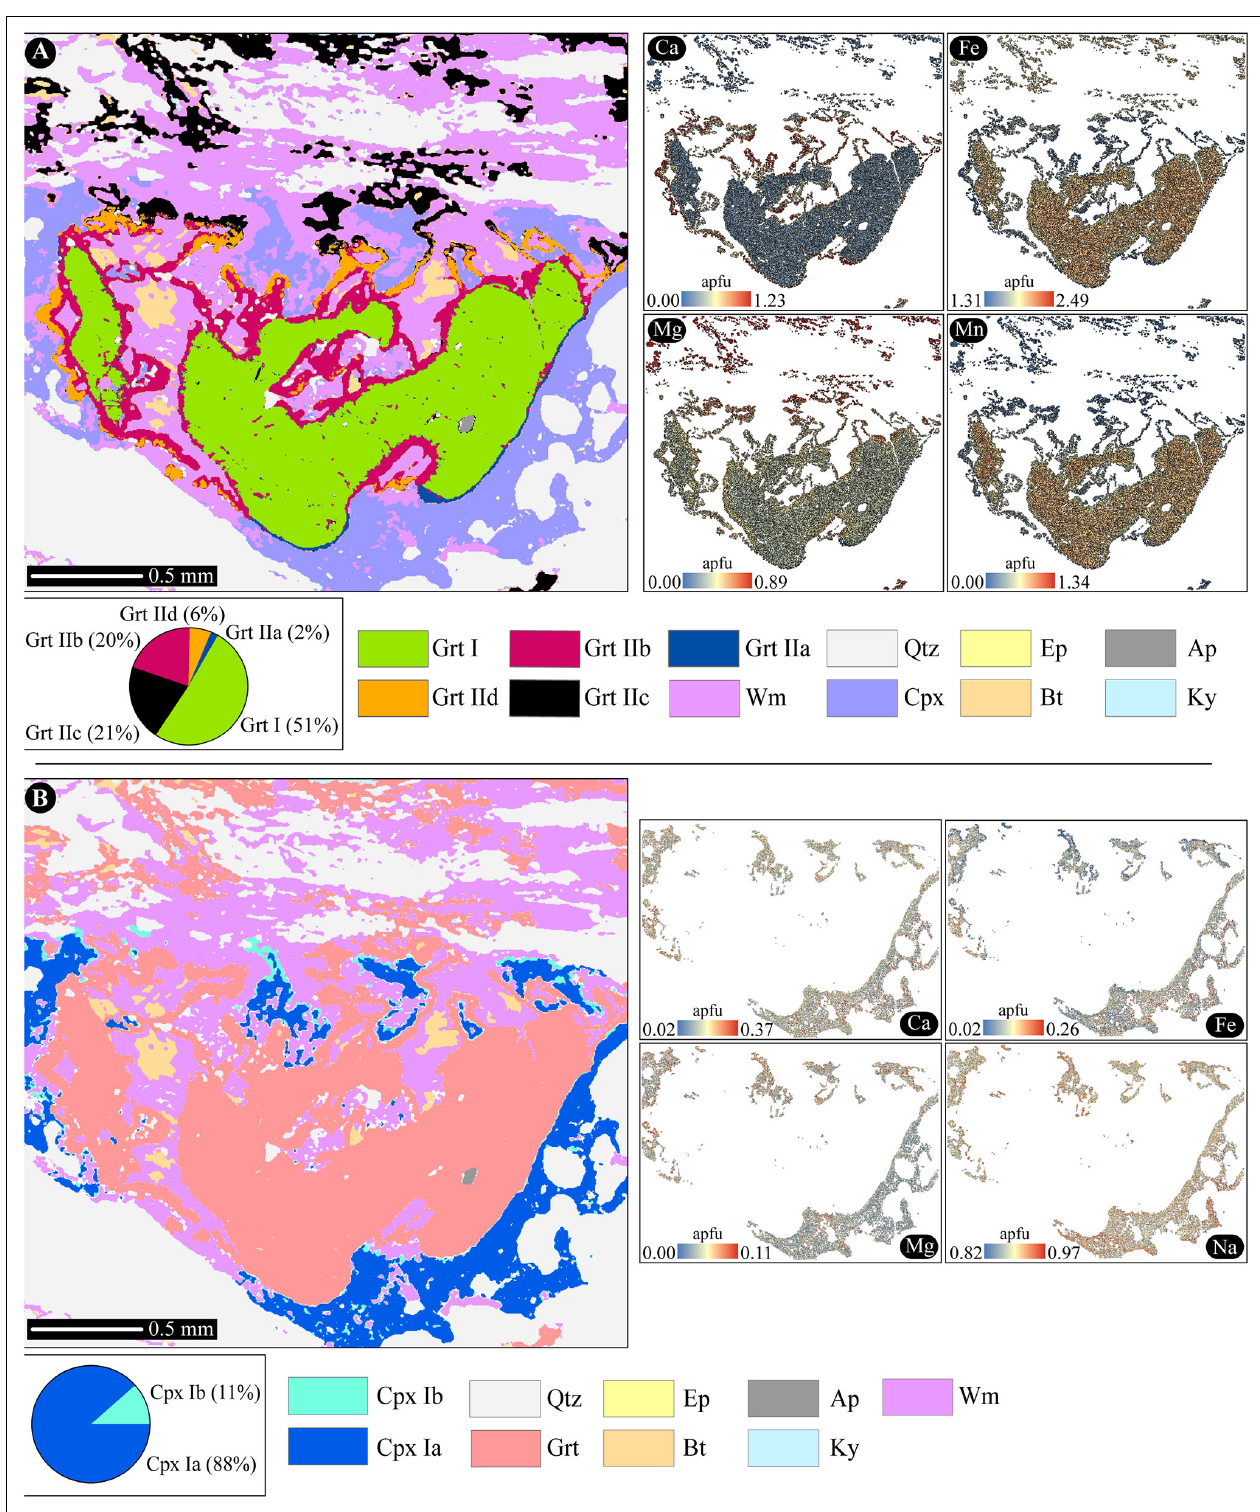
FIGURE 7 | Results of second cycle of Q-XRMA procedure for pre-alpine Grt microdomain. (A) Grt sub-phases classification and their modal percentage. Calibration maps of Ca, Fe, Mg, and Mn contents in Grt. (B) Cpx sub-phases classification and their modal percentage. Calibration maps of Ca, Fe, Mg, and Na contents in Cpx.